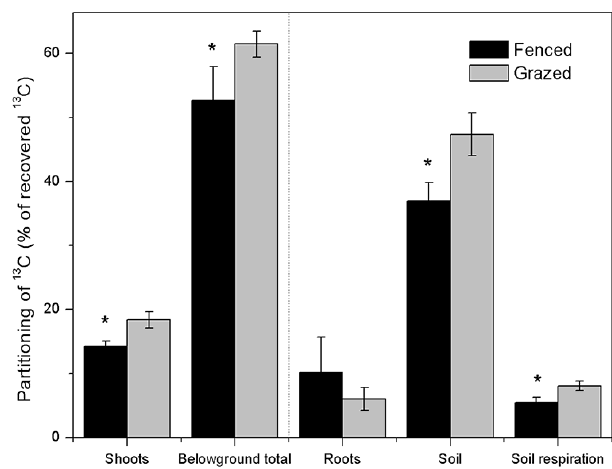
Figure 2. Partitioning of 13 C (percentage of recovered 13 C) in shoots and belowground of the fenced and control grazed meadows at day 32 of the chase period. The partitioning of 13 C (percentage of recovered 13 C) in belowground stocks was divided into three parts, including roots, soil stocks and loss by soil respiration (right side of figure). ∗ Indicates significant differences at P < 0 . 05 between the fenced and grazed meadows. Data are means ± standard deviation ( n =